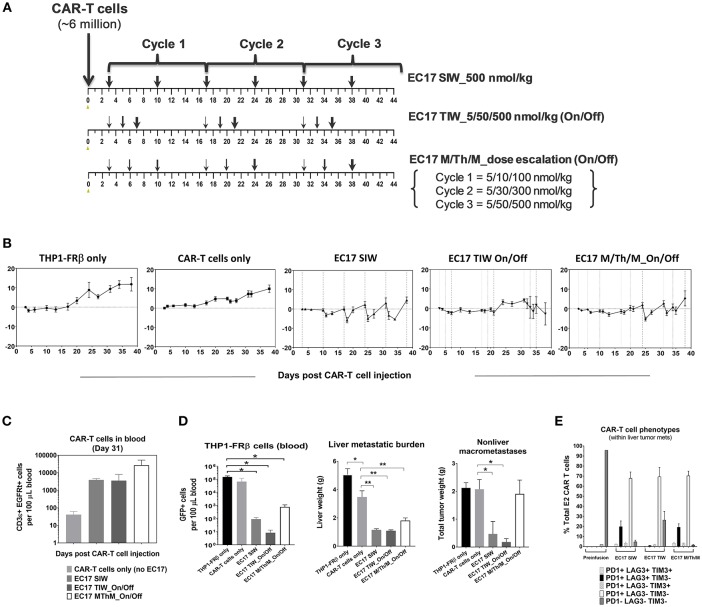
EC17 dose escalation in safety and anti-leukemic activity in-vivo. (A) Schematic diagrams to show dose scheduling of EC17 plus unsorted EGFRt CAR-T cells (~6 million, day 0) in NSG mice with 1 day-old intravenous THP1-FRβ xenografts. Starting 3 days after CAR-T cell injection, EC17 was dosed in 3 different ways: EC17 SIW 500 nmol/kg (5 total doses on days 3, 10, 17, 24, 31, and 38), EC17 TIW 5/50/500 nmol/kg (3 repeats of 5/50/500 nmol/kg on Monday/ Wednesday/Friday followed by a 9 day break, i.e., on days 3/5/7, 17/19/21, and 31/33/35), or EC17 M/Th/M_dose escalation on Monday/Thursday/Monday (3 escalation cycles at 5/10/100 nmol/kg in Cycle 1, 5/30/300 nmol/kg in Cycle 2, and 5/50/500 nmol/kg in Cycle 3, i.e., on days 3/6/10, 17/20/24, and 31/34/38). (B) Measurements of change in body weight (n = 5). (C) Circulating CAR-T cells as human CD3ε+ EGFRt+ events found per 100 μL of mouse whole blood on a logarithmic scale on day 31. (D) Left bar graph: circulating tumor cells (GFP+) per 100 μL of whole blood in all cohorts measured at the end of study (day 39); Middle bar graph: THP1-FRβ infiltrated liver weights representing liver metastatic burden; Right bar graph: total tumor weights of all non-liver macrometastases. (E) Flow cytometric analysis of T-cell exhaustion markers, PD1, LAG3, TIM3, on preinfusion CAR-T cell product (triple-negative) and tumor-infitrating CAR-T cells isolated from liver metastases. A cardinal feature of fully exhausted T cells is co-expression of multiple inhibitory receptor markers (i.e., triple-positive) (39). *p < 0.05; **p < 0.01.